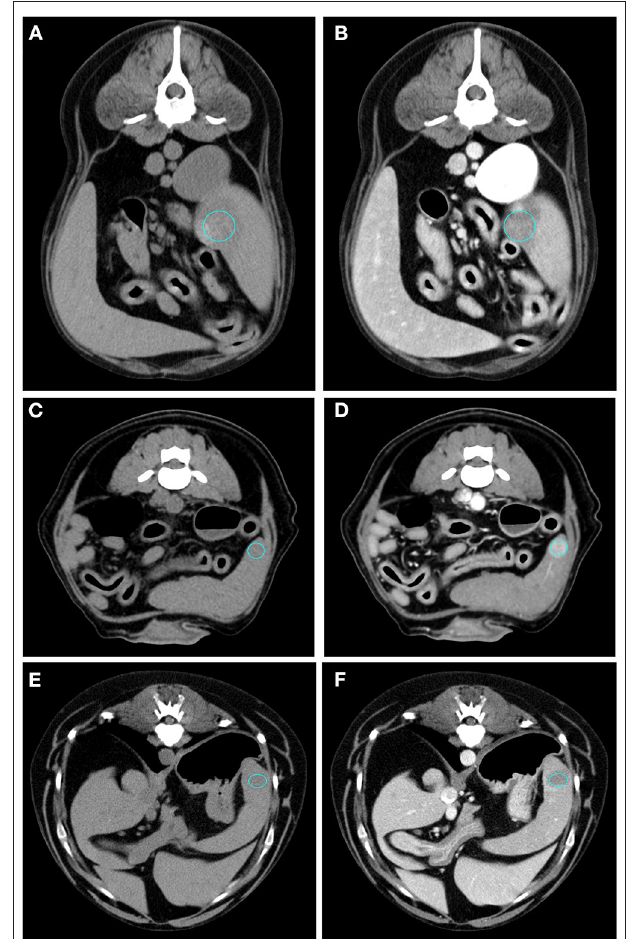
FIGURE 2 | Pre- (A) and post- (B) contrast images of an OBL (diagnosed as extramedullary haematopoiesis) showing hypoattenuation and hypoenhancement, diffuse enhancement pattern with heterogeneous distribution, well-defined margins, irregular surface, and solid appearance. Pre- (C) and post- (D) contrast images of an OBL (diagnosed as extramedullary haematopoiesis) showing isoattenuation and hyperenhancement, diffuse enhancement pattern with homogeneous distribution, well-defined margins, regular surface, and solid appearance. Pre- (E) and post- (F) contrast images of an OBL (diagnosed as haematoma) showing hypoattenuation and hypoenhancement, diffuse enhancement pattern with heterogeneous distribution, well-defined margins, regular surface, and cyst-like appearance. The ROI is placed inside the